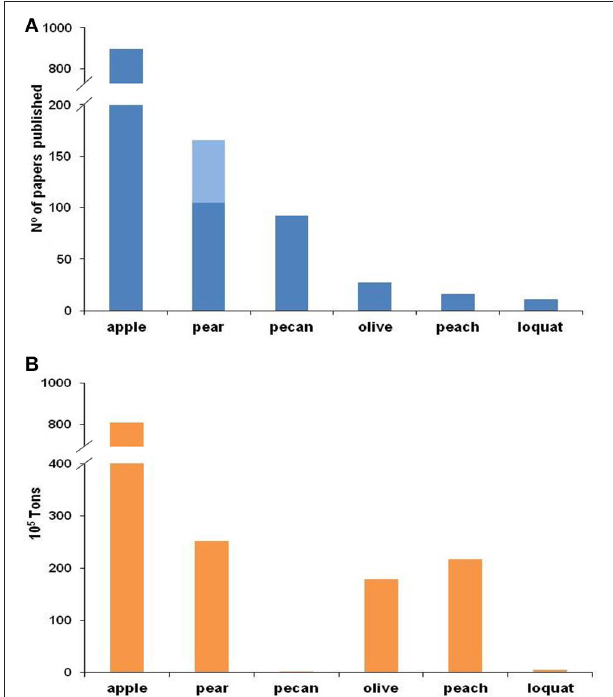
FIGURE 1 | Number of papers published on scab (A) and worldwide production (B) for each fruit crop. For (A) , the Web of Science was searched on 30 August 2016 for different combinations of words in the title (for apple: “ Venturia inaequalis” or “ Fusicladium pomi ” or “ Spilocaea pomi ” or “apple scab”; for pear: “ Venturia pyrina ” or “ Venturia pirina ” or “ Fusicladium pyrorum ” or “pear scab” and in light blue “ Venturia nashicola ” or “ Fusicladium nashicola ”; for pecan: “ Fusicladium effusum ” or “ Cladosporium effusum ” or “ Cladosporium caryigenum ” or ”pecan scab”; for olive “ Spilocaea oleagina ” or “ Fusicladium oleagineum ” or “olive scab” or “olive leaf spot”; for peach: “ Venturia carpophila ” or “ Fusicladium carpophilum ” or “ Cladosporium carpophilum ” or “peach scab”; and for loquat: “ Fusicladium eriobotryae ” or “ Spilocaea eriobotryae ” or “loquat scab”). Worldwide production data for (B) were extracted from FAOSTAT, except in the case of loquat, where data from González-Domínguez (2014) were